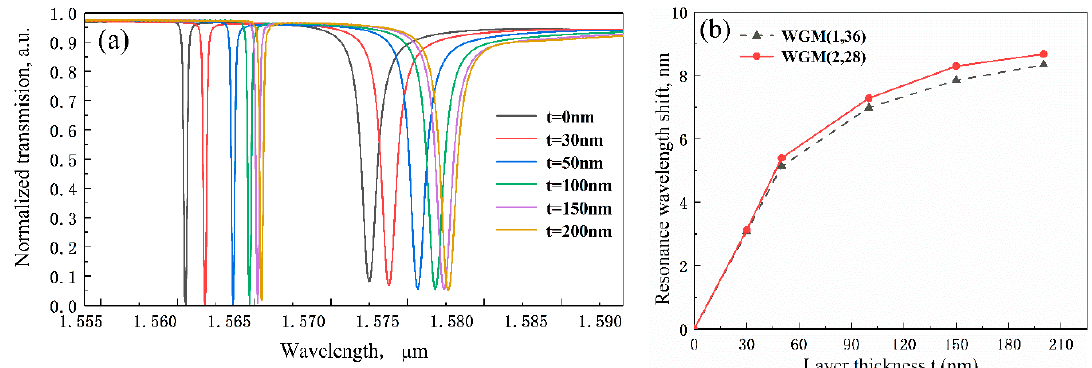
Figure 6. ( a ) The transmission spectra of the MDR with different adsorbed analyte layer thickness. ( b ) Resonance wavelength shifts of the MDR versus the layer thickness.